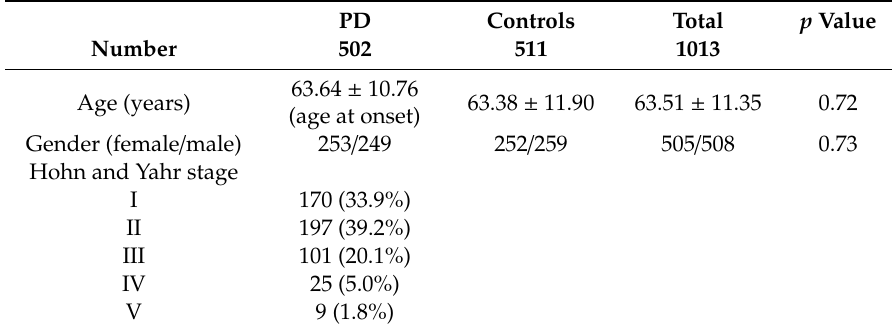
Table 1. Demographics and clinical characteristics of Parkinson’s disease (PD) patients and control